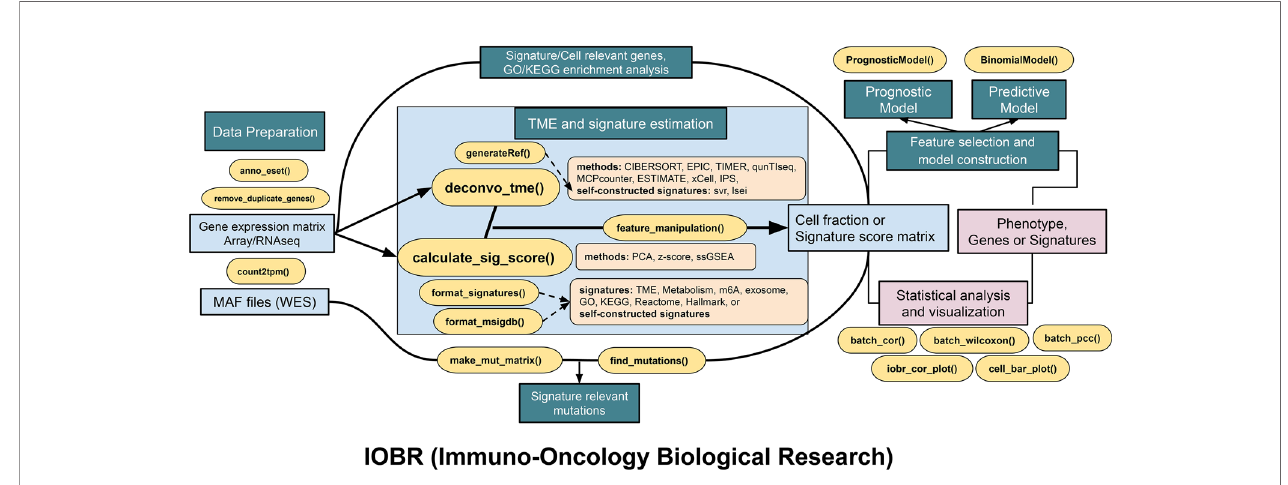
FIGURE 2 | The pipeline diagram depicts functions of four analytic modules contained in IOBR. In addition to the functions for data preprocessing, the function modules comprise the following: (1) analyses of signatures pertinent to clinical phenotype, lncRNA, and targeted signatures constructed based on bulk RNA-seq or scRNA-seq data and TME deconvolution; (2) identi fi cation of phenotype relevant signatures, cell fraction, or signature genes, as well as corresponding batch statistical analyses and visualization; (3) an estimation of the speci fi c mutation landscape associated with the signature of interest; and (4) model construction following feature